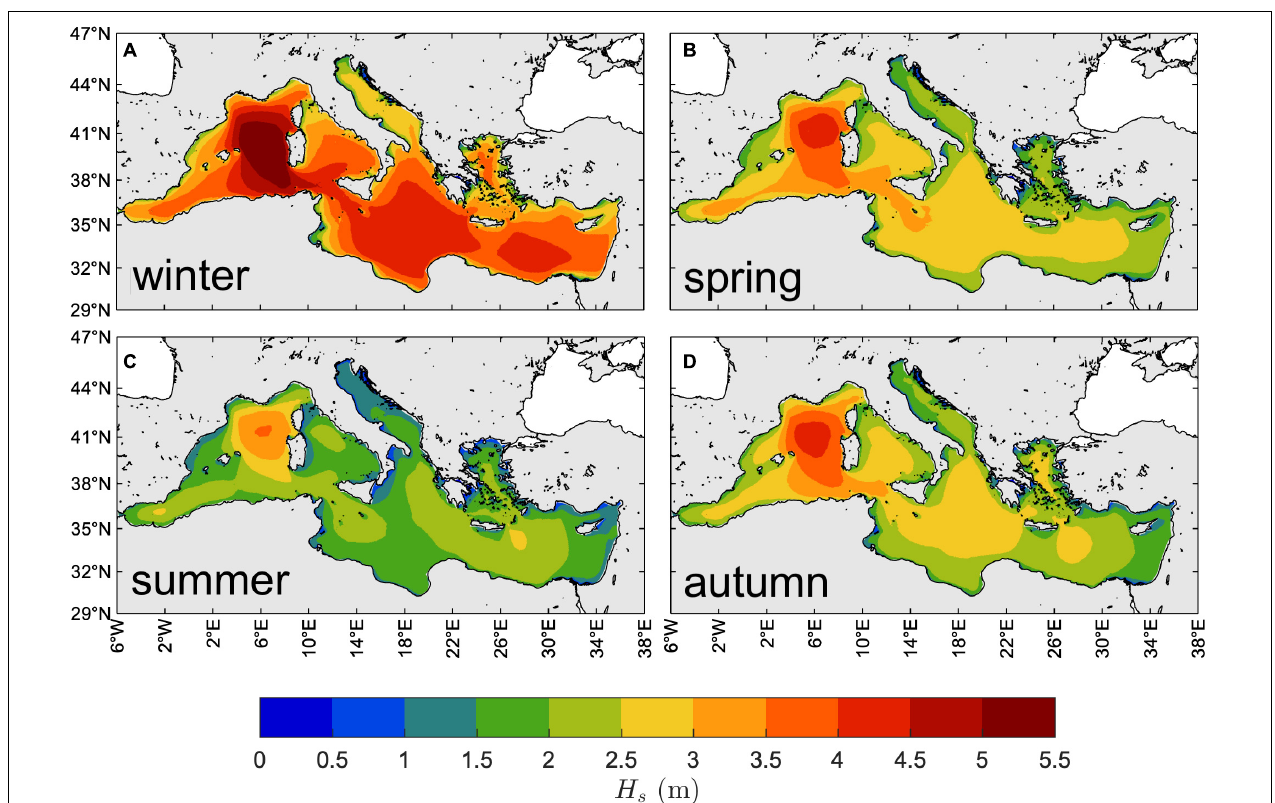
FIGURE 5 | Climate of extreme MS wind waves. Yearly-averaged seasonal 99th percentile of H s (1981–2019): winter [NDJFM, panel (A) ], spring [AM, panel (B) ], summer [JJA, panel (C) ], and autumn [SO, panel (D) ].